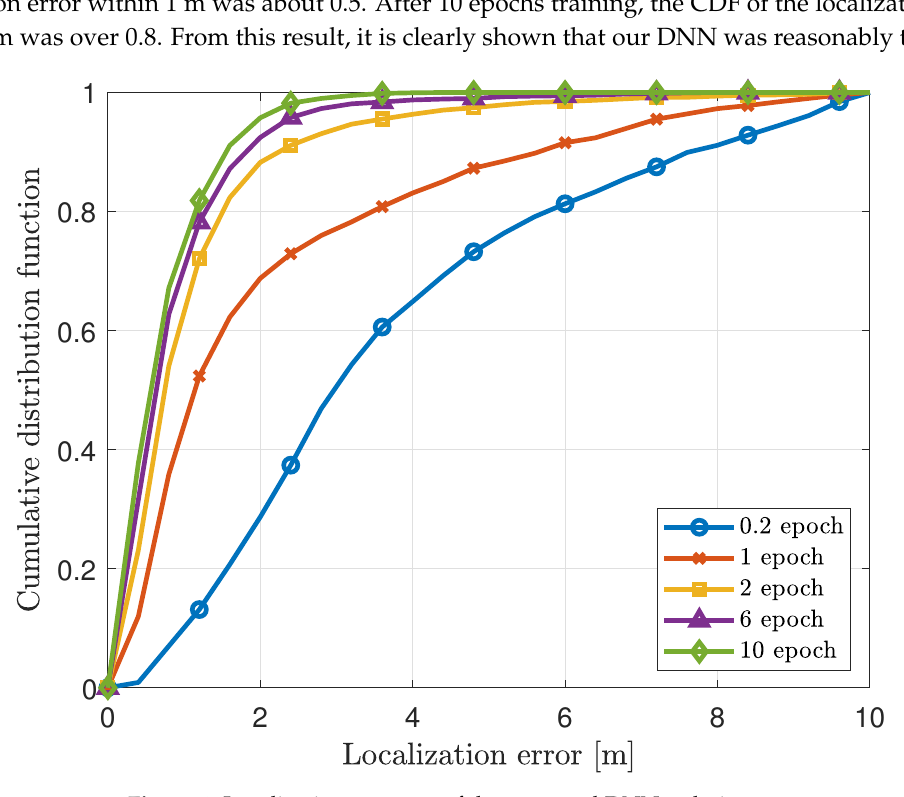
Figure 4. Localization accuracy of the proposed DNN